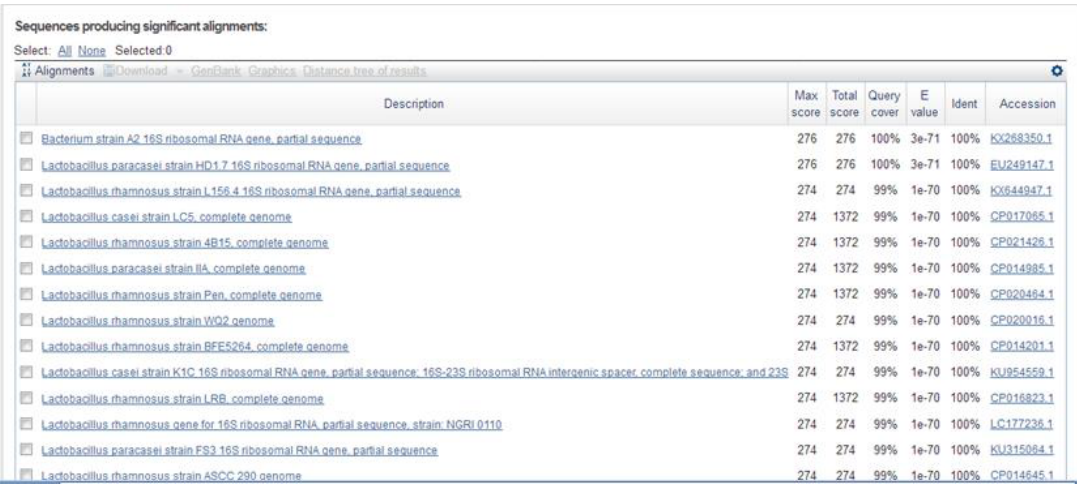
Figure 4. The result of molecular identification of lactid acid bacteria showing Lactobacillus paracasei